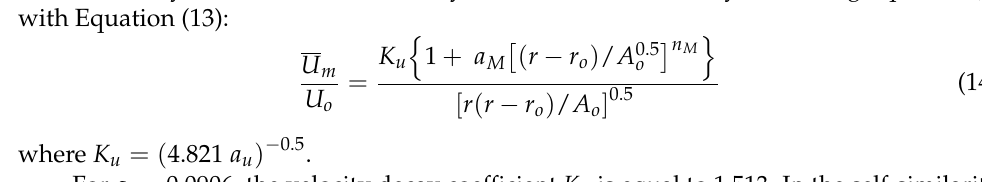
Table 3. The gross and integral parameters of the tested RWJs from multi-cone and plate diffusers. Multi-Cone Diffuser Plate Diffuser